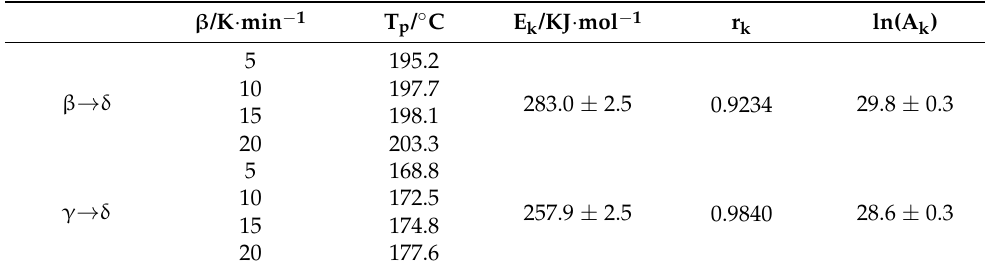
Figure 9. Summary of the thermally induced reconstructive phase transitions of HMX. Table 3. Arrhenius parameters for the β → δ and γ → δ transformations.